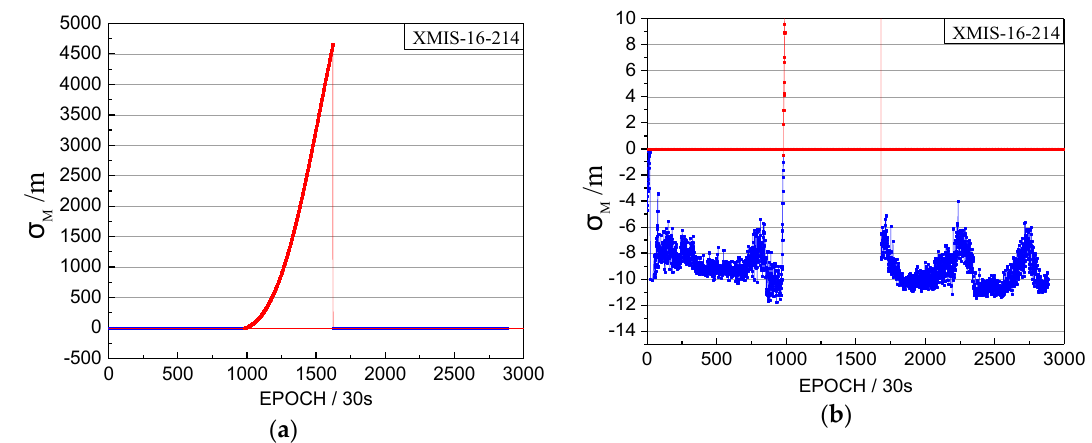
Figure 8. The time factors of the orbital maneuver for the XMIS station on 1 August 2016. ( a ) The normal vertical axis scale shows overall information; ( b ) The amplified vertical axis scale shows more detailed information. Sensors 2017 , 17 , 2761